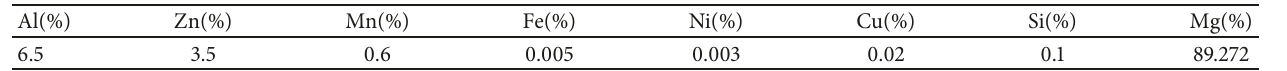
Figure 1: E-t curves of magnesium sacrificial anode with different influencing factors. Table 2: Magnesium alloy sacrificial anode